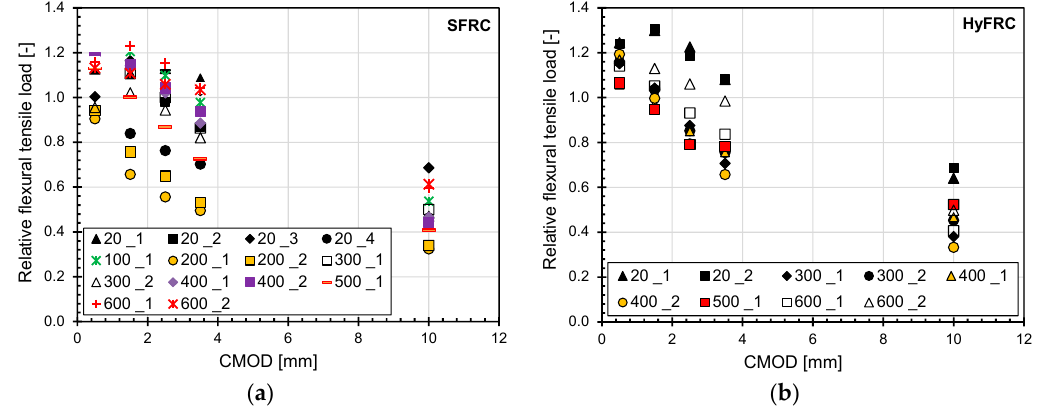
Figure 11. Influence of elevated temperature on the ductility of ( a ) SFRC and ( b ) HyFRC.